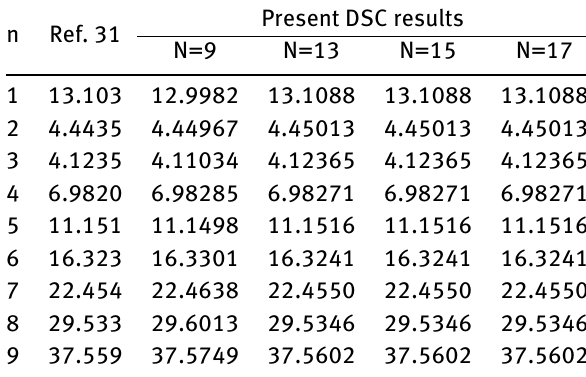
Table 2: Types of FGM circular shell for each layer (surface) Table 3: Comparative study of natural frequency of FG circular cylin- drical shell with simply supported edges